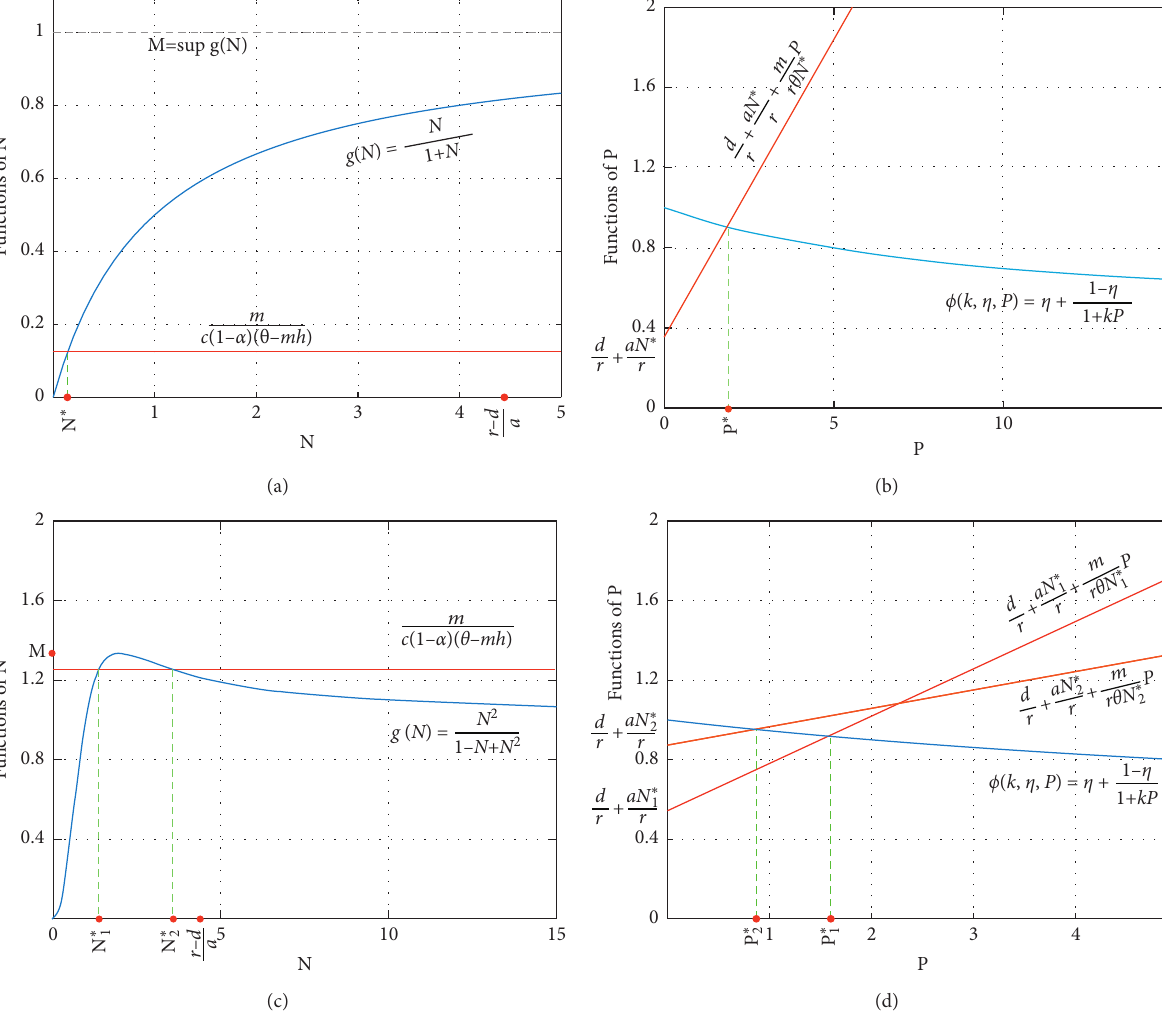
Figure 1: Geometrical explanation for existence of coexistence steady state(s). Here, N ∗ is the intersection of the curve F ( N ) � g ( N ) and 1 ( N ) � ( m / c ( 1 − α )( θ − mh )) . For this particular N ∗ , P ∗ is the meet point of the curve F ( P ) � ϕ ( k, η ,P ) and the line the horizontal line F 1 2 ( P ) � ( d / r ) + ( aN ∗ / r ) + ( m / r θ N ∗ ) P . (a, b) The horizontal line F ( N ) � ( m / c ( 1 − α )( θ − mh )) intersects the increasing g ( N ) at exactly F 2 1 one point provided conditions (17) and (18) are fulfilled, and the corresponding P ∗ will be possible if (19) holds. (c, d) Multiple coexistences may occur when g ( N ) is a nonmonotonic function. Particular forms of g ( N ) and ϕ ( k, η ,P ) are mentioned in the figure. Parameters values are taken as r � 0 . 6 , η � 0 . 4 ,k � 0 . 1 ,d � 0 . 2 , α � 0 . 6 , a � 0 . 09 , c � 0 . 5 ( 0 . 4 ) ,h � 0 . 007 , θ � 0 . 4 ,m � 0 . 01 ( 0 . 08 ) 􏼈 􏼉 . Values in the first bracket corresponding to c and m are used for plotting the last two